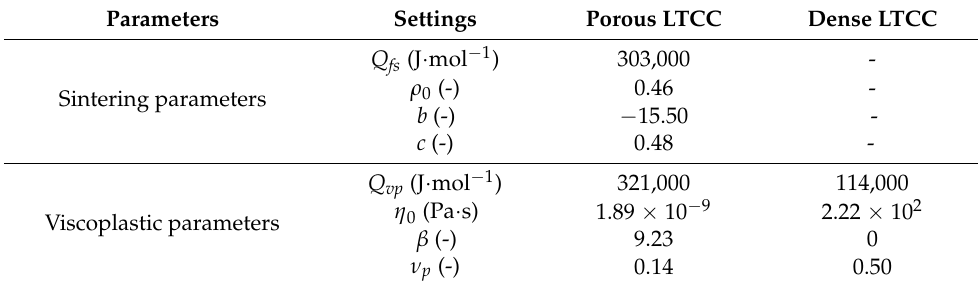
Table 1. Sintering and viscoplastic parameters of the LTCC